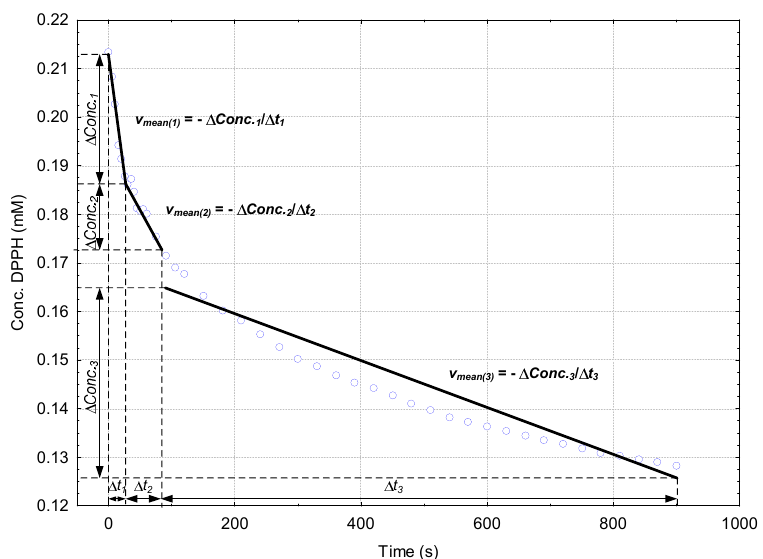
Figure 5. Schematic representation of the calculus of the mean DPPH · reaction rates ( v mean(1–3) ) from the linear correlations of the Concentration (DPPH·) versus Time plots for the specific time ranges: 0–30 s (Δ t 1 ), 30–80 s (Δ t 2 ) and 80–900 s (Δ t 3 ).